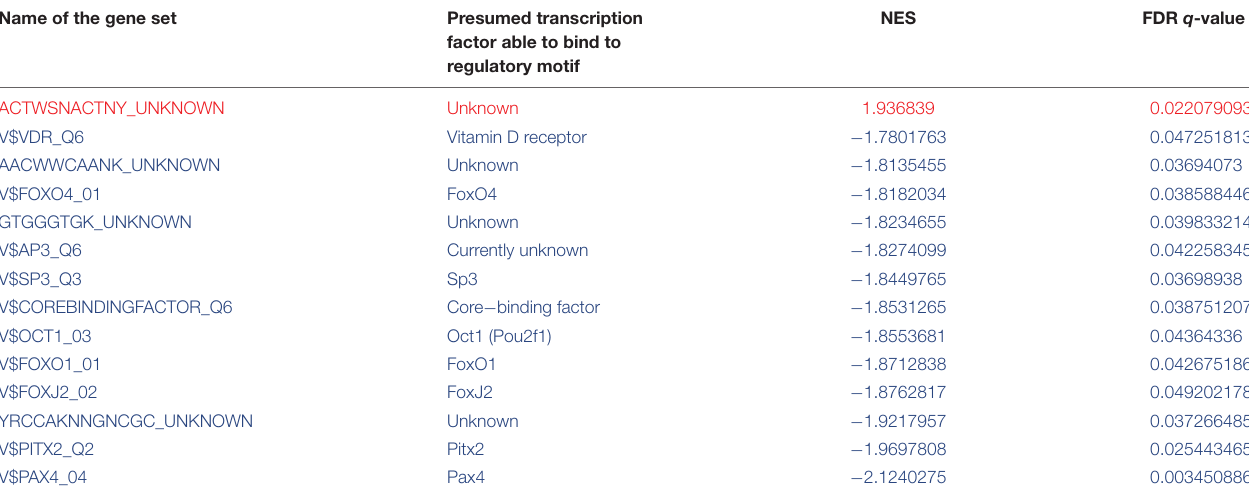
TABLE 1 | Up- and downregulated transcription factor gene sets 3 weeks after a single-dose MDMA treatment in the hippocampus of Dark Agouti rats. Name of the gene